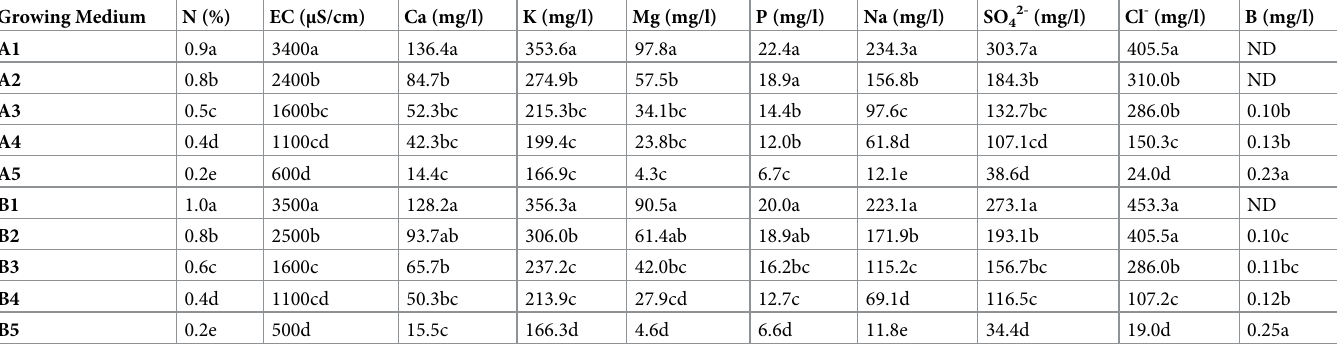
Table 4. Mineral nutrients concentration of vermicast-sawdust mixed media without (A) and with (B) addition of Trichoderma viride during a 90-day incubation period. Growing Medium